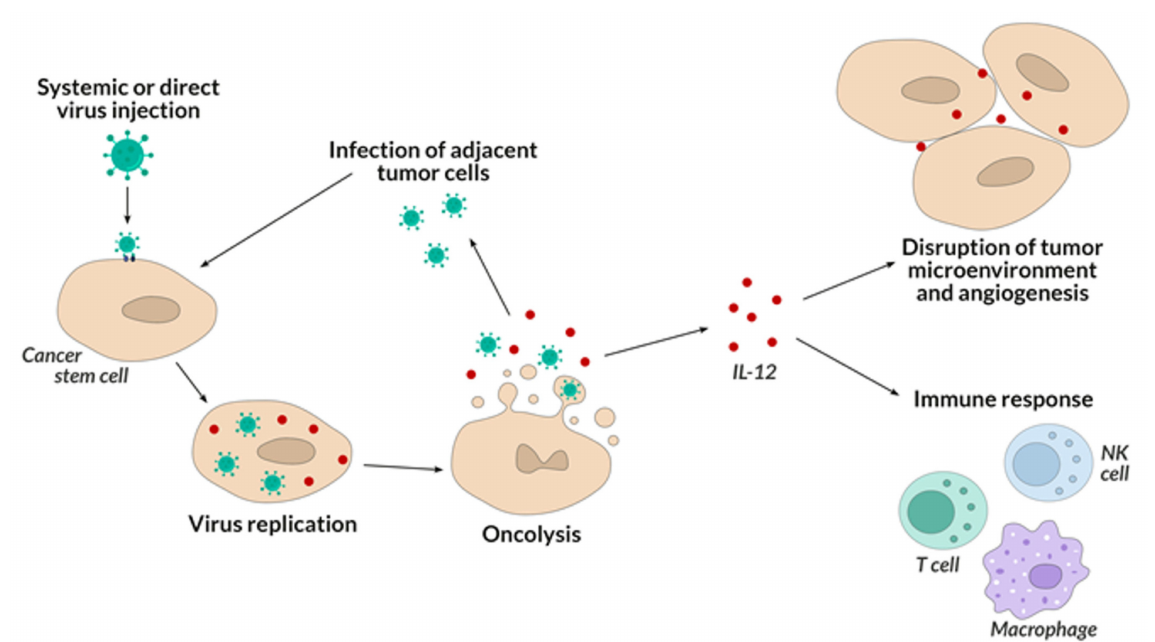
Figure 3. The effects of oncovirus therapy. Oncolytic viruses selectively replicate and lyse cancer cells compared to normal cells which lack these